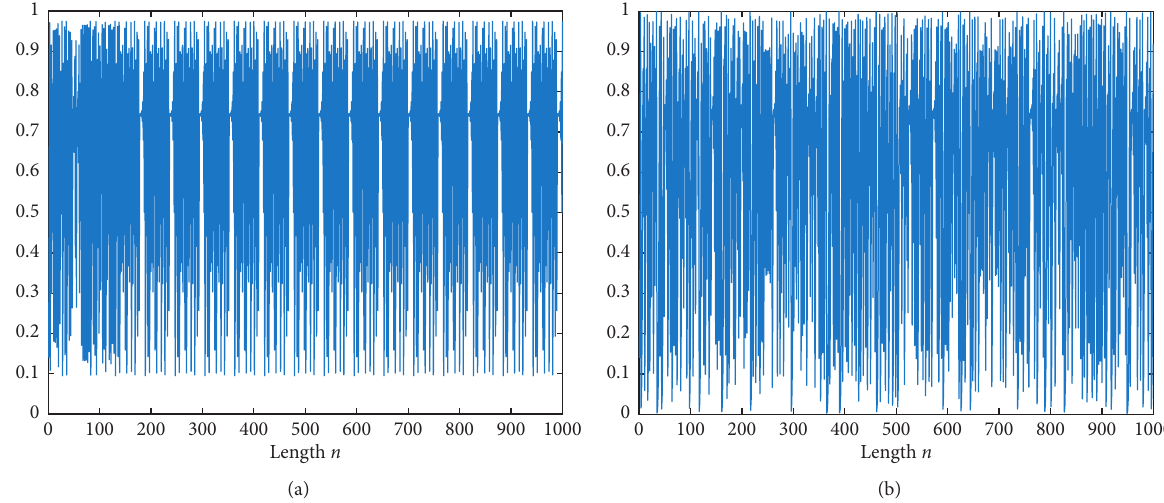
Figure 1: The trajectories of two maps. (a) Digital logistic map; (b) iteration-time combined digital logistic